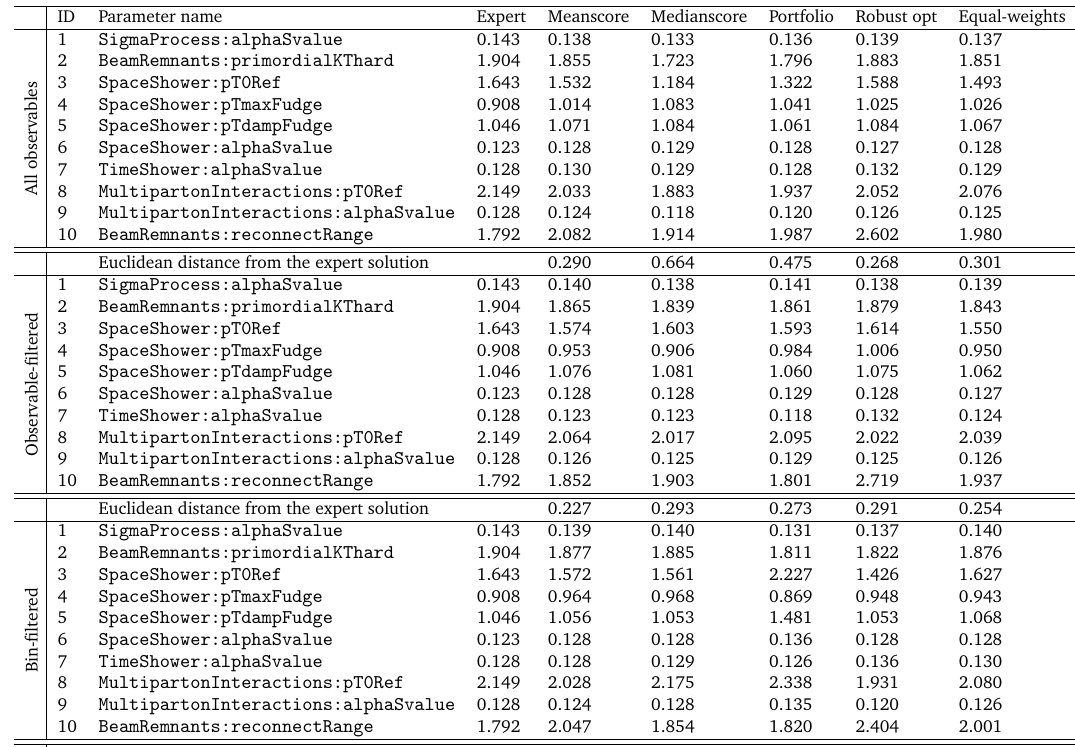
Table 6: Optimal parameter values for the A14 dataset when using the rational ap- proximation in the optimization. Euclidean distances are calculated based on the normalized parameter